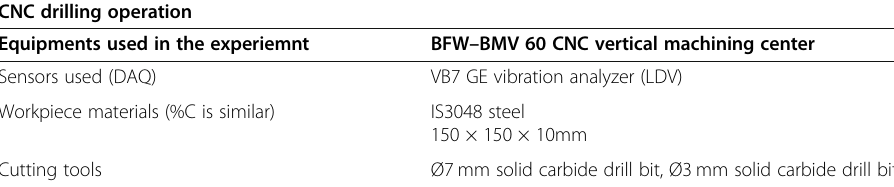
Table 2 Proposed experimental test setup CNC drilling operation